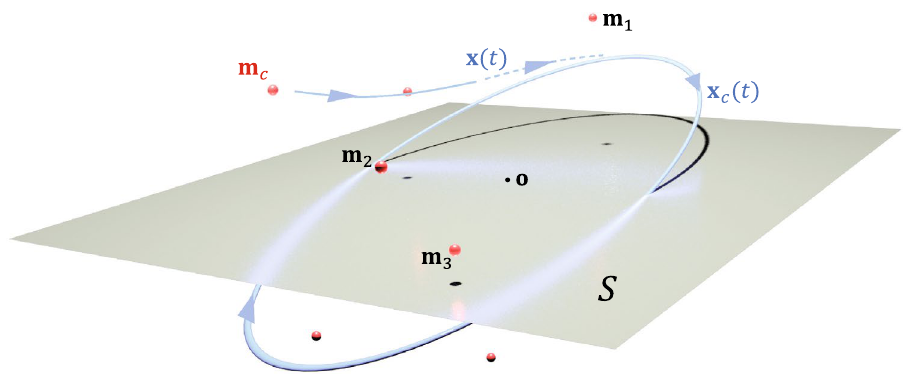
Figure 1. Graphical illustration of the memory representations m 1 , . . . , m n and the corresponding